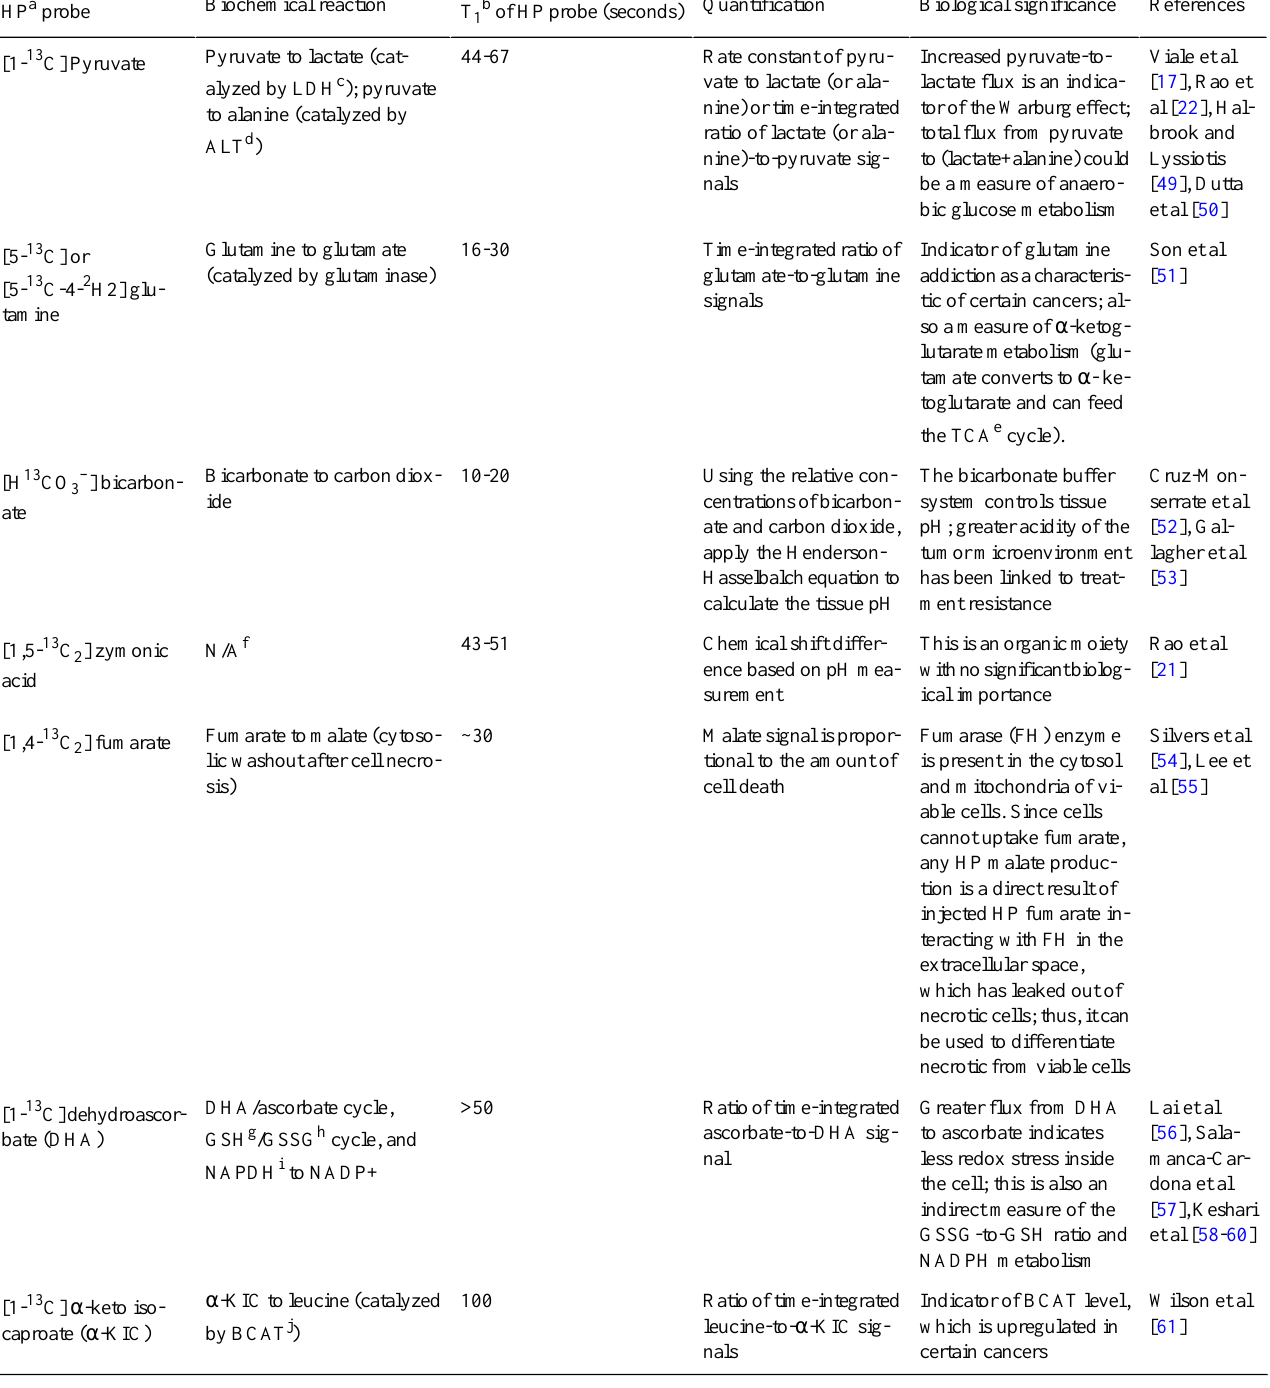
Table 1. Review of 13C-labeled probes employed in interrogating different metabolic pathways in pancreatic cancer